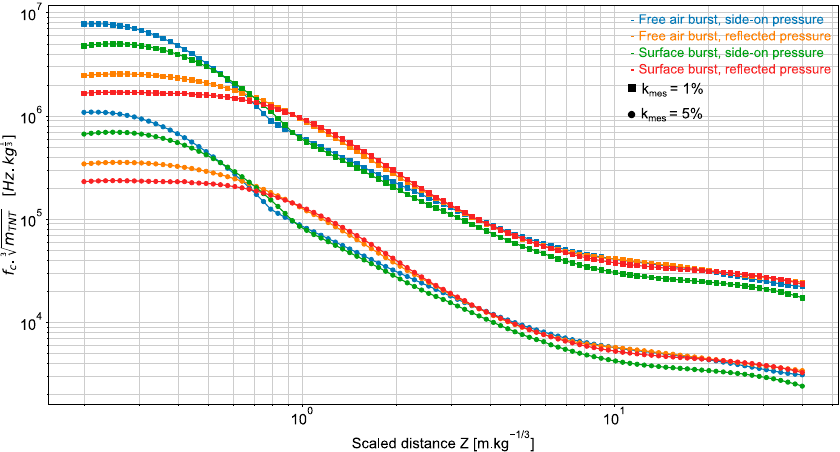
√ (cid:0) (cid:1) Figure 4. Scaled frequency bandwidth ( √ 𝑚 (cid:3021)(cid:3015)(cid:3021) (cid:3119) 𝑓 (cid:3030) ) as a function of the scaled distance 𝑍 for ensur- m TNT f c Figure 4. Scaled frequency bandwidth as a function of the scaled distance Z for ensuring 3 ing an estimation accuracy 𝑘 𝑚𝑒𝑠 of the overpressure peak magnitude of 1% (square marker) and an estimation accuracy k mes of the overpressure peak magnitude of 1% (square marker) and 5% 5% (point marker). The ground truth overpressure ∆𝑃 (cid:3014)(cid:3002)(cid:3025) is obtained from K&B data. (point marker). The ground truth overpressure ∆ P MAX is obtained from K&B